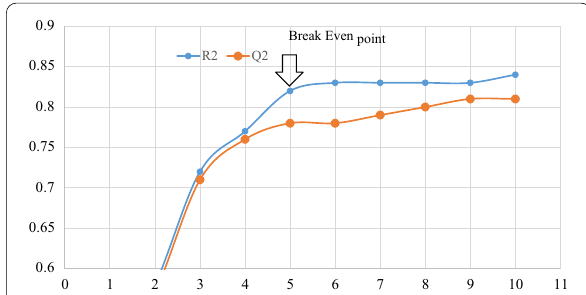
Selection of dataset from ChEMBL & its Curation 2D Structure sketch, 3D convertion and optimization PyDescriptor Calculation and its trimming Splitting of dataset into training and test set(80:20)